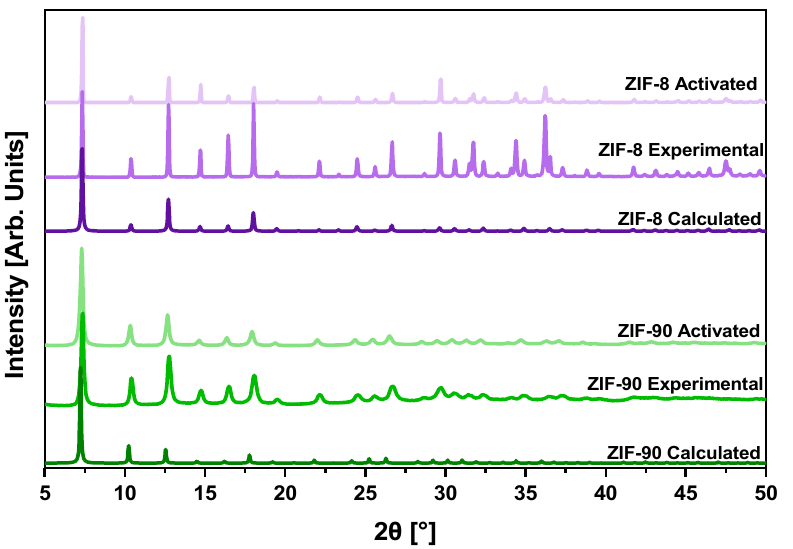
Figure 1. PXRD patterns of calculated, experimental and activated ZIF-8 (SOD) and ZIF-90 (SOD). Table 2. Crystalline size (nm) of ZIF-8 and ZIF-90 calculated from PXRD. ZIF Crystalline Size (nm) ZIF-8 400 ZIF-90